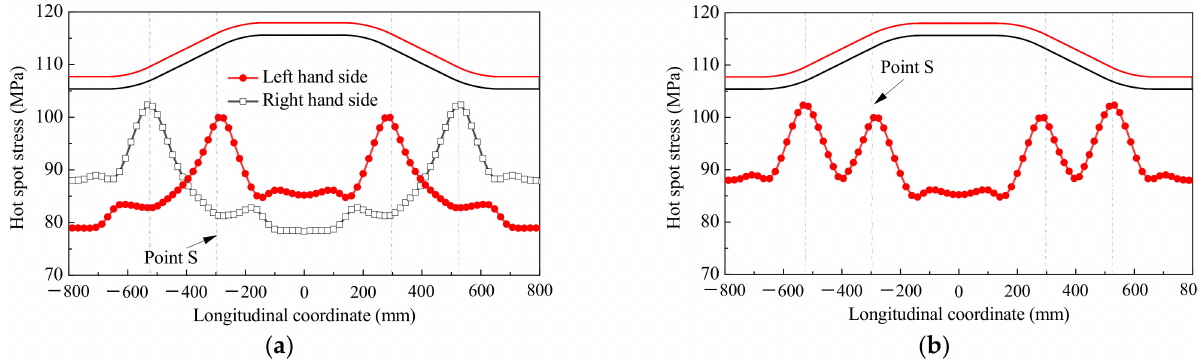
Figure 20. Analysis of hot-spot stress distribution: ( a ) hot-spot stress distribution; ( b ) envelope of hot-spot stress.